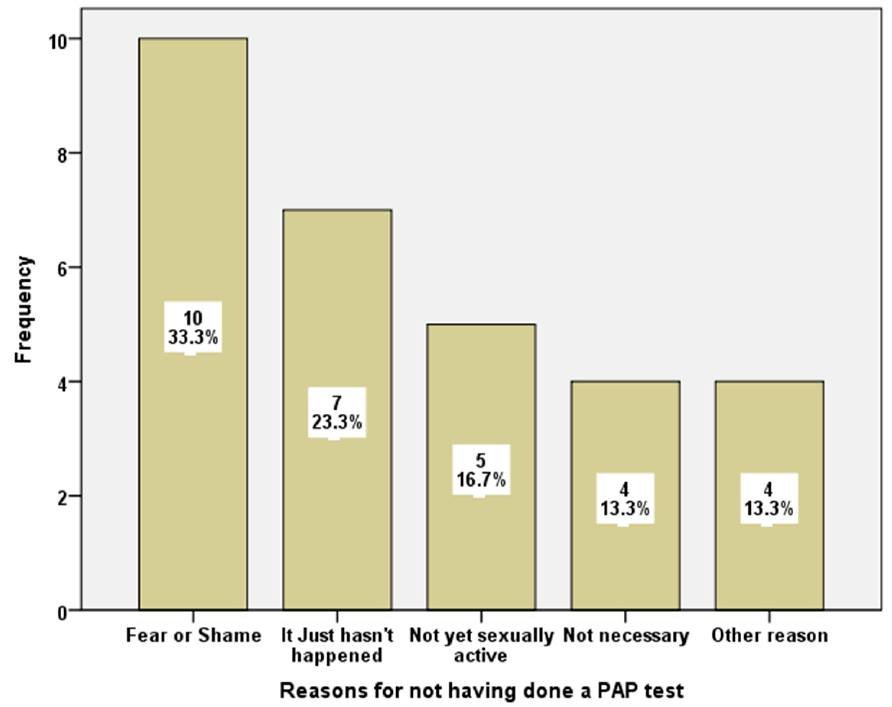
Figure 1. Reasons for not having done a PAP test.